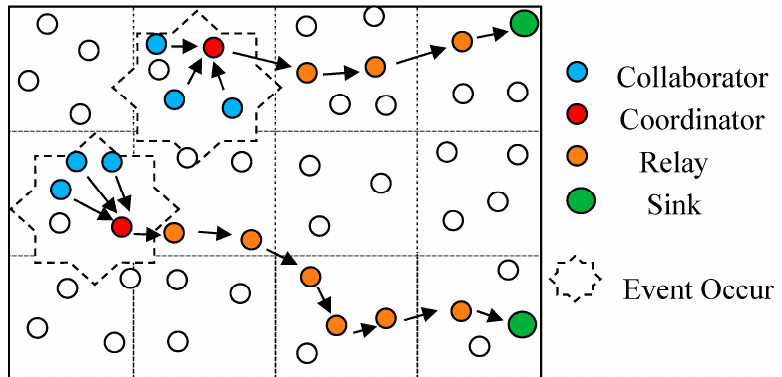
Figure 3. Roles of nodes in the clustered environment.